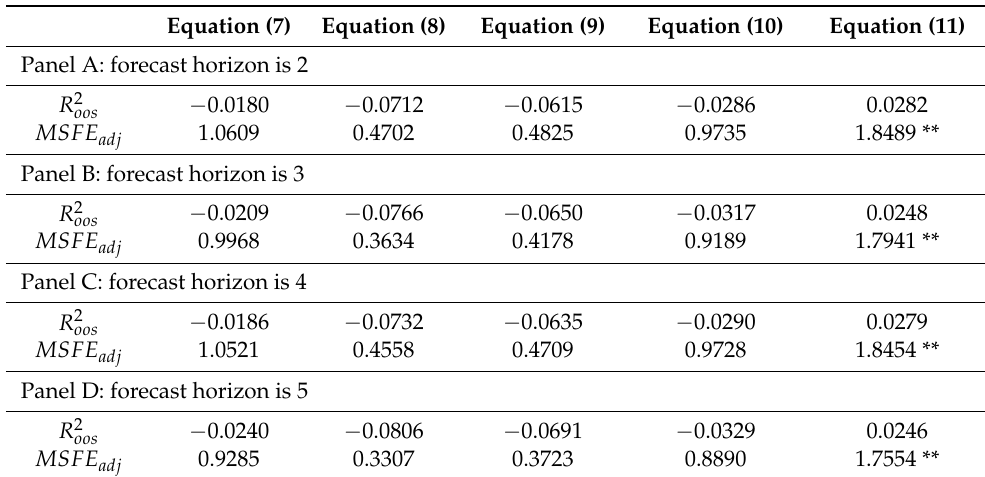
Table 8. Long horizons forecasts during out-of-sample.